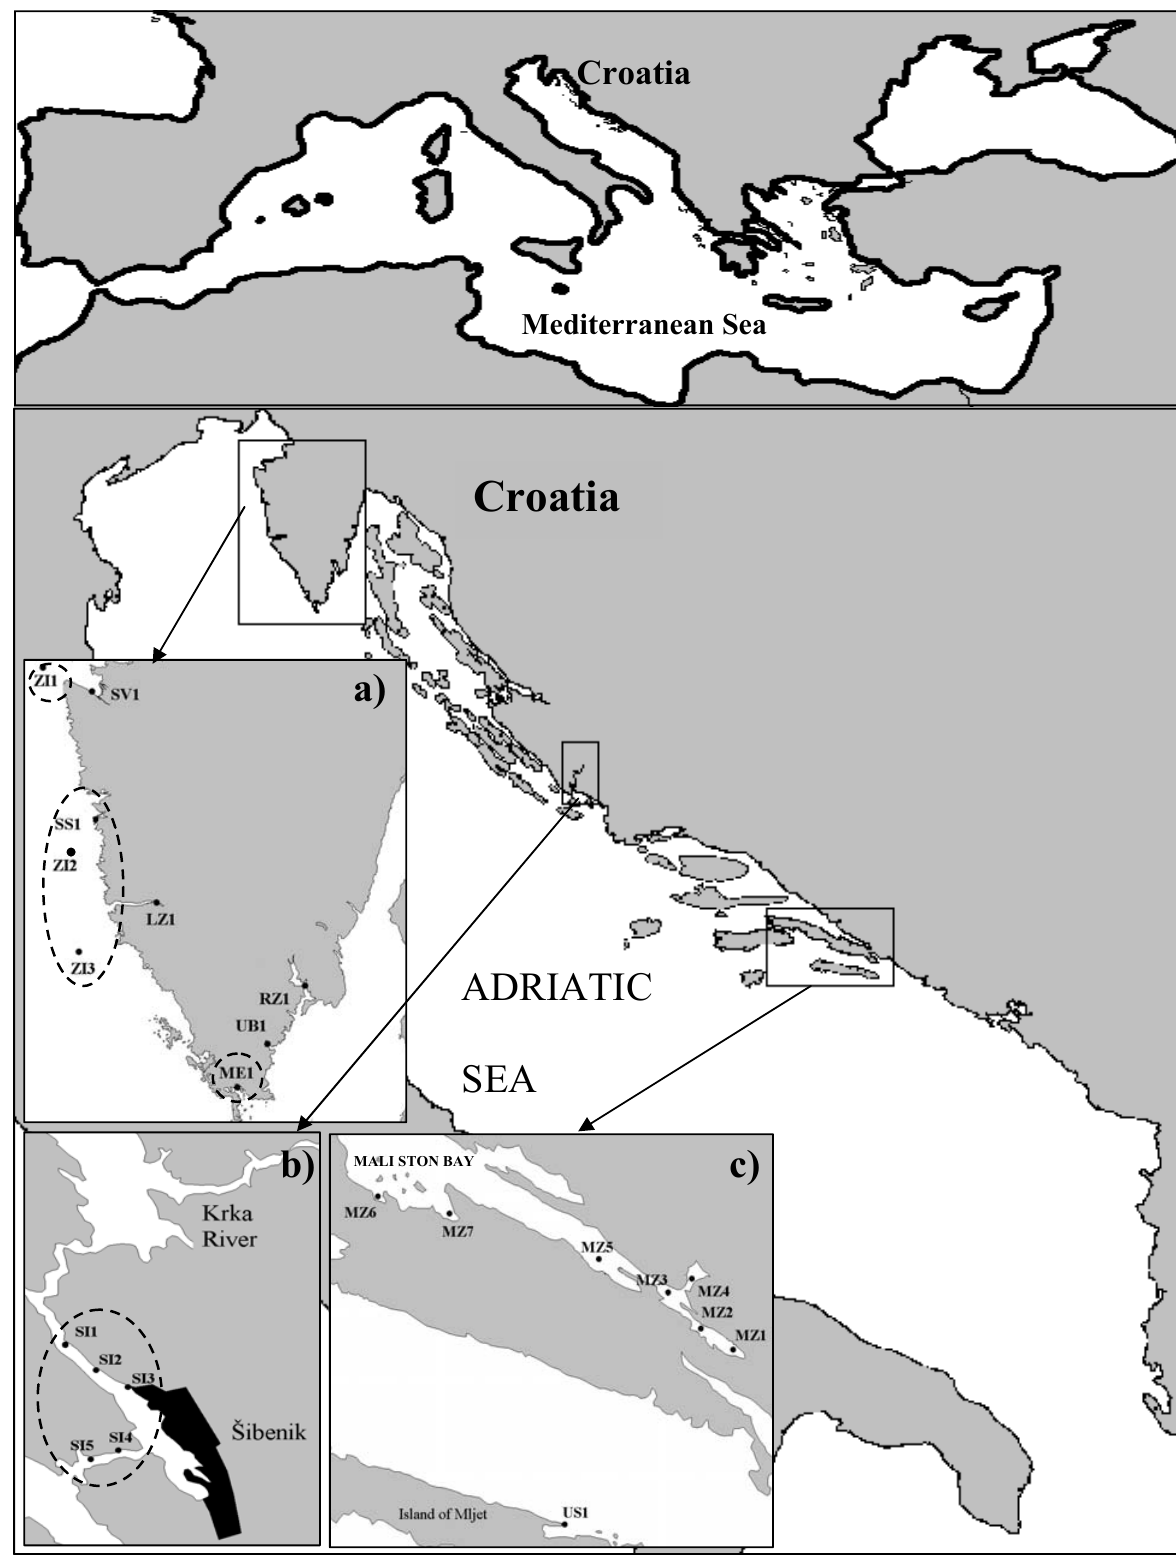
Figure 6. Area of DA and phytoplankton community investigation along Croatian Adriatic coast comprise of 22 shellfish breeding and 4 harvesting areas (ZI1, ZI2, ZI3 and SI4) in three zones: North Adriatic (a), Central Adriatic (b) and South Adriatic (c). Stations where domoic acid was appeared are framed with dashed